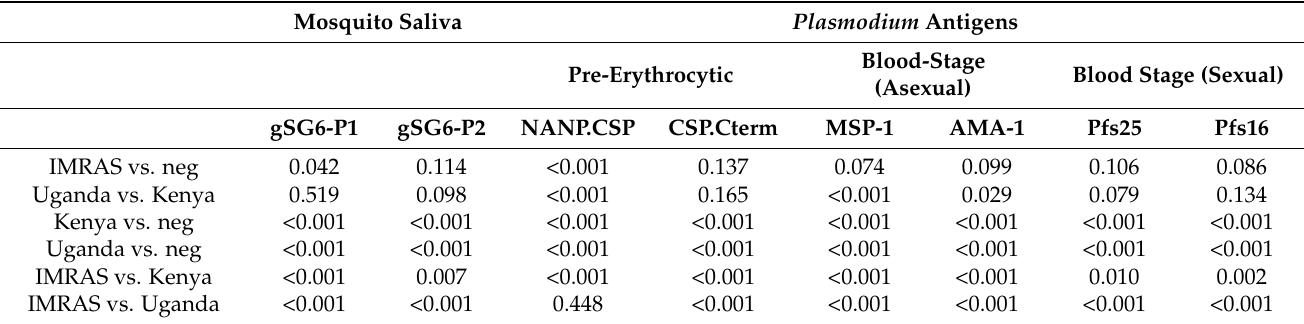
Table 1. Statistically significant differences in antibody reactivities.